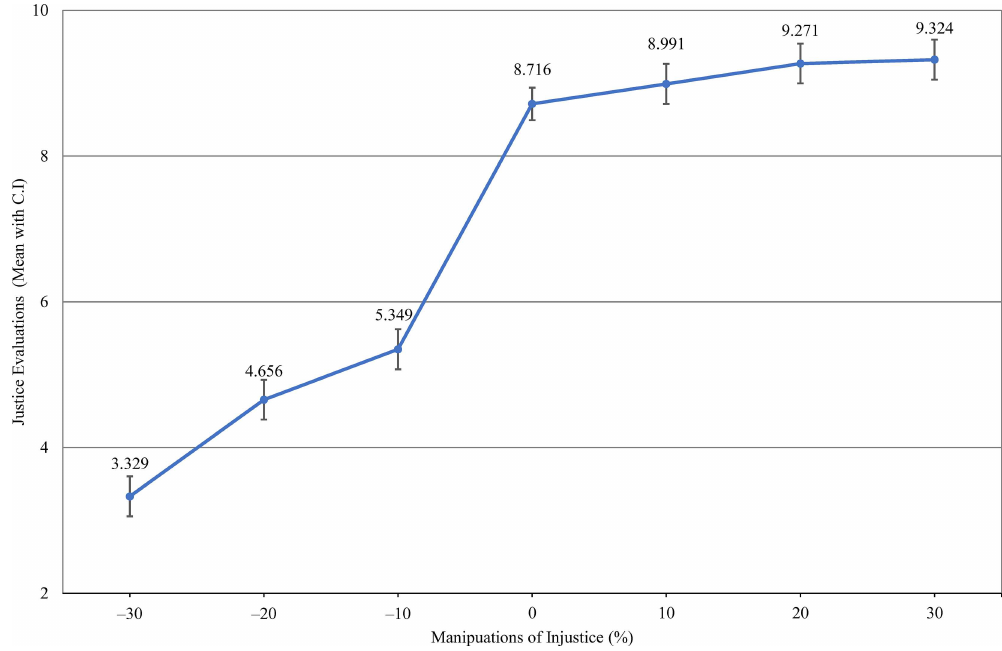
Fig 3. Justice Evaluations across the Level of